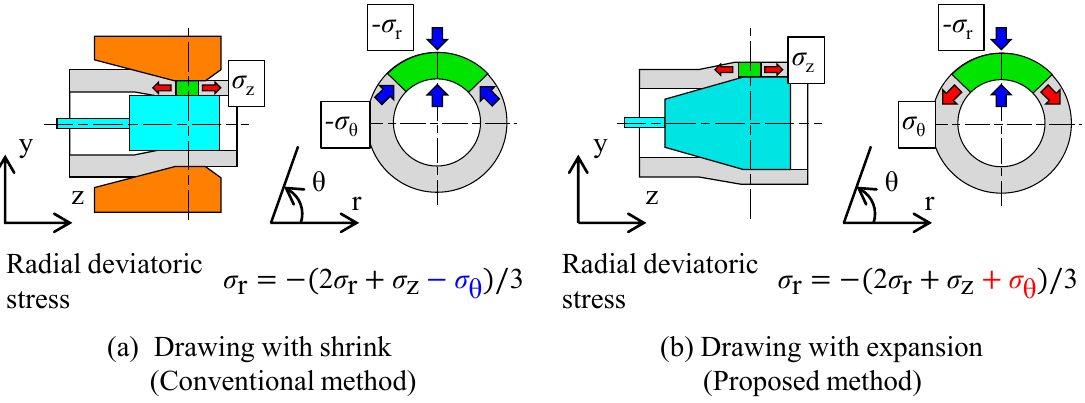
Figure 2. Stress state of tube wall during drawing with shrink and drawing with expansion.